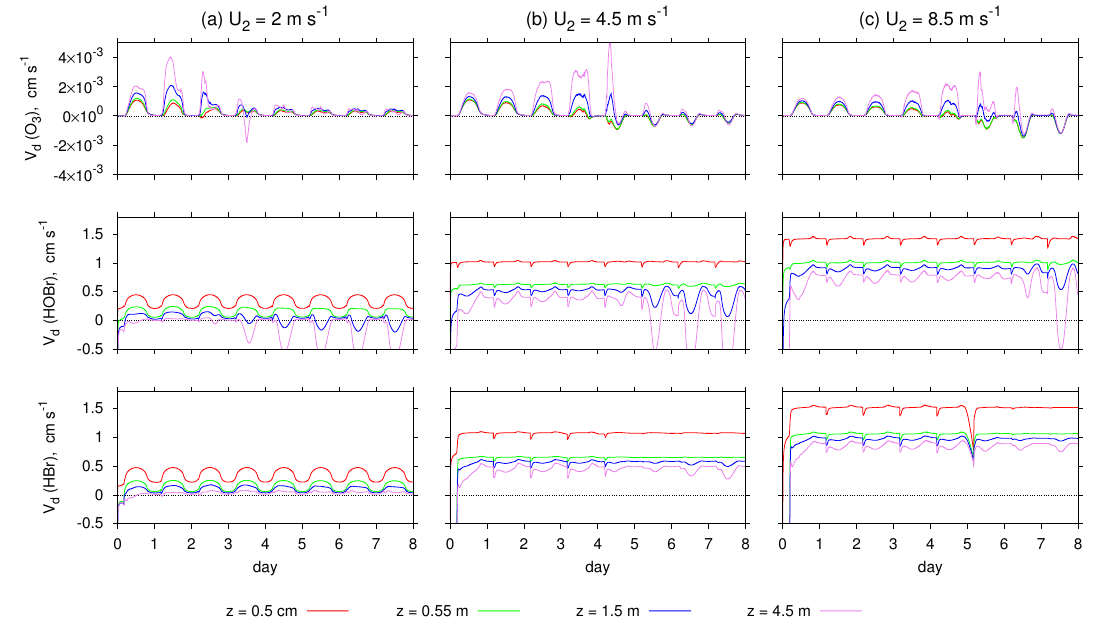
Fig. 15. Apparent dry deposition velocities (at 0.5cm, 55cm, 1.5m, and 4.5m above the snow surface) of O 3 (top row), HOBr (middle row) and HBr (bottom row) from model runs with U 2 = 2.0ms − 1 (a) , 4.5ms − 1 (b) and 8.5ms − 1 (c)